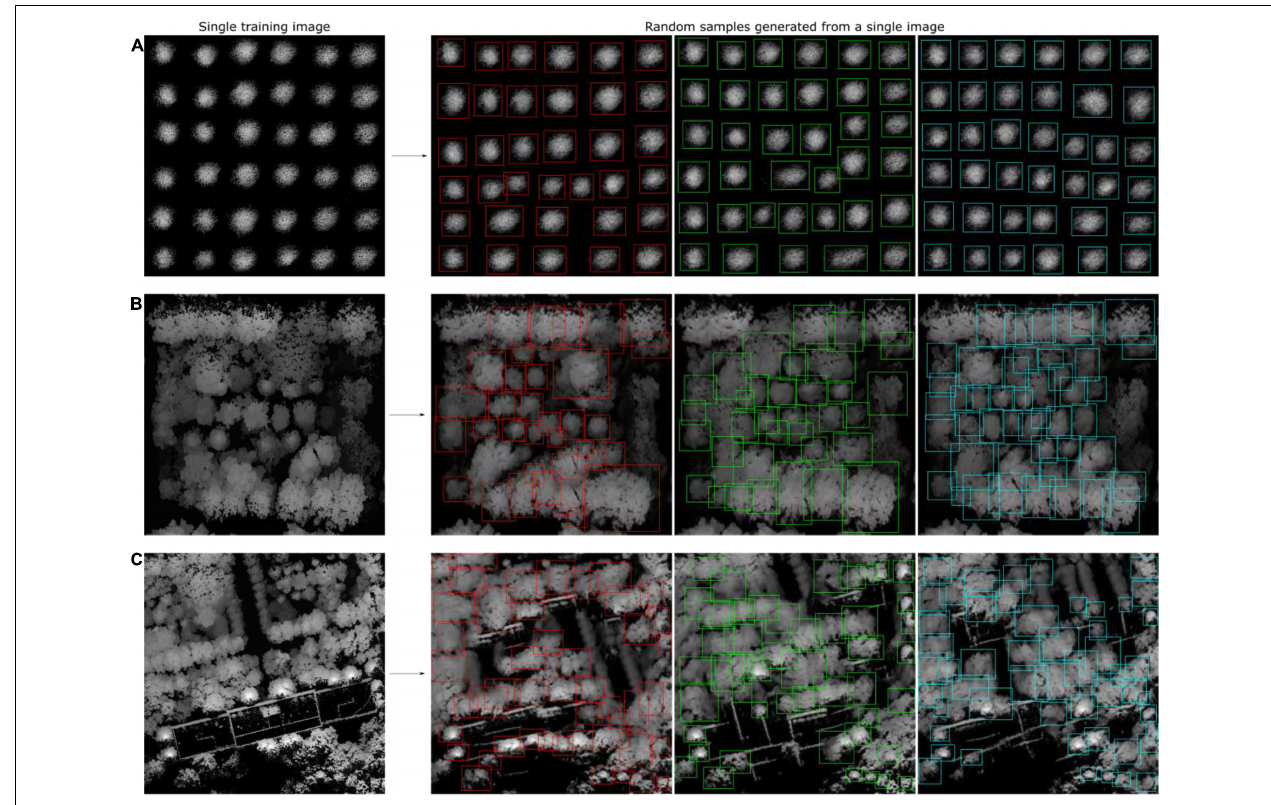
FIGURE 14 | SinGAN was used to generate the heightmaps of a forest plot. Diagrams showing the generated synthetic heightmaps of (A) the tree nursery, (B) the forest landscape area, and (C) the mixed tree habitat. Although a portion of the generated image is slightly fuzzy, most of the tree crowns can be visually identified. Thus, these images with the tree crowns in the synthetic heightmaps manually labeled using the LabelImg tool can be used as new training